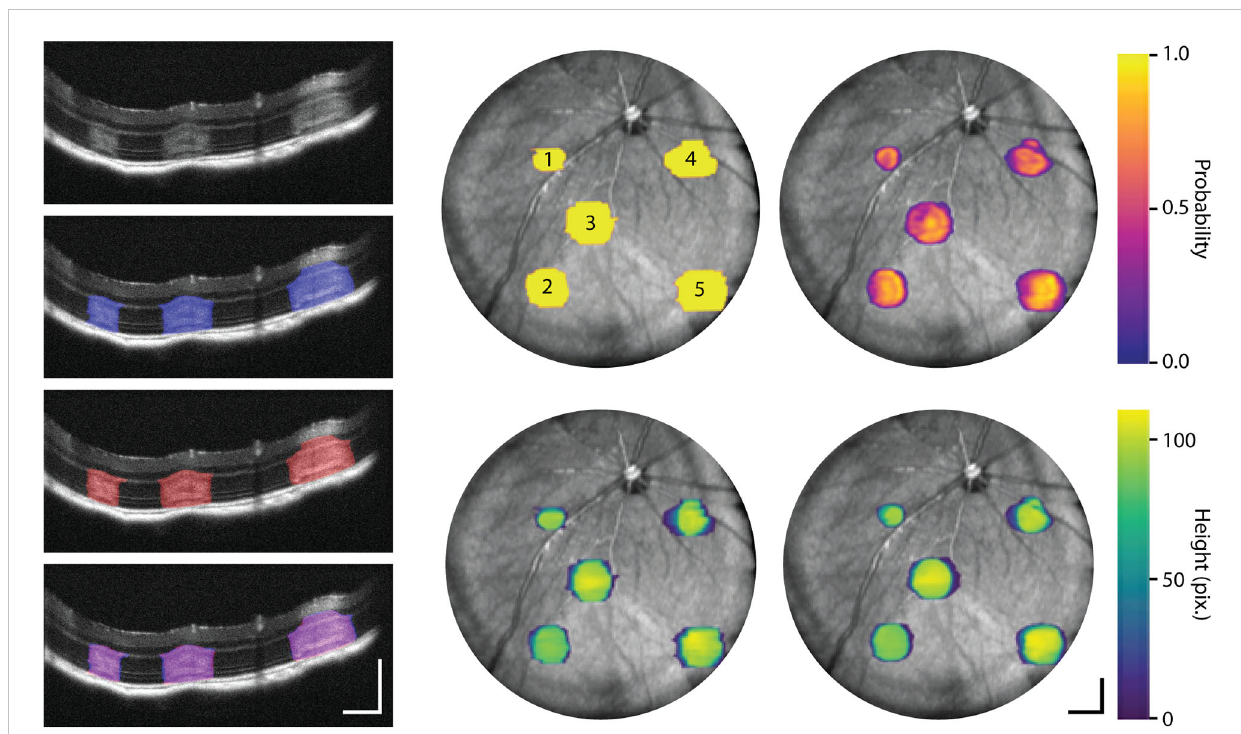
FIGURE 9 Machine-learning-based segmentation of laser lesions on OCT. Lesions were created with 4 repeated 100 ms pulses with 10, 20, 30, 40, 50 mW power (labeled 1-5, respectively). OCT cross-sections of laser lesions with manual (blue), automated (red), and manual/automated overlap (purple) labeling (Supplemental Video 4). En face OCT projections show neural network segmentation (right column) probability maps indicating level of certainty in delineating lesions and OCT thickness of each lesion as compared to the corresponding manually labeled volumes (middle column). Scale bar: 250